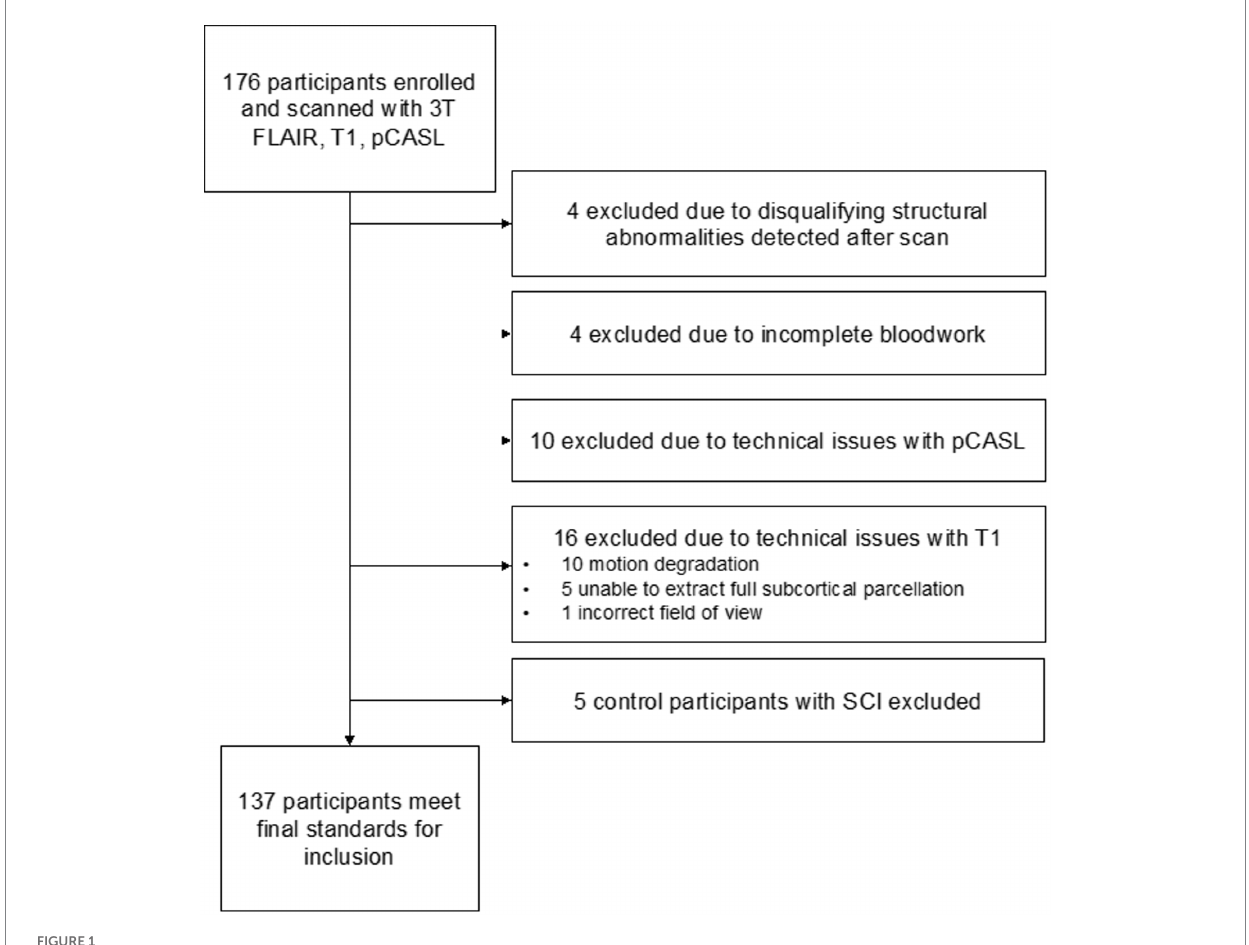
FIGURE 1 Study exclusion